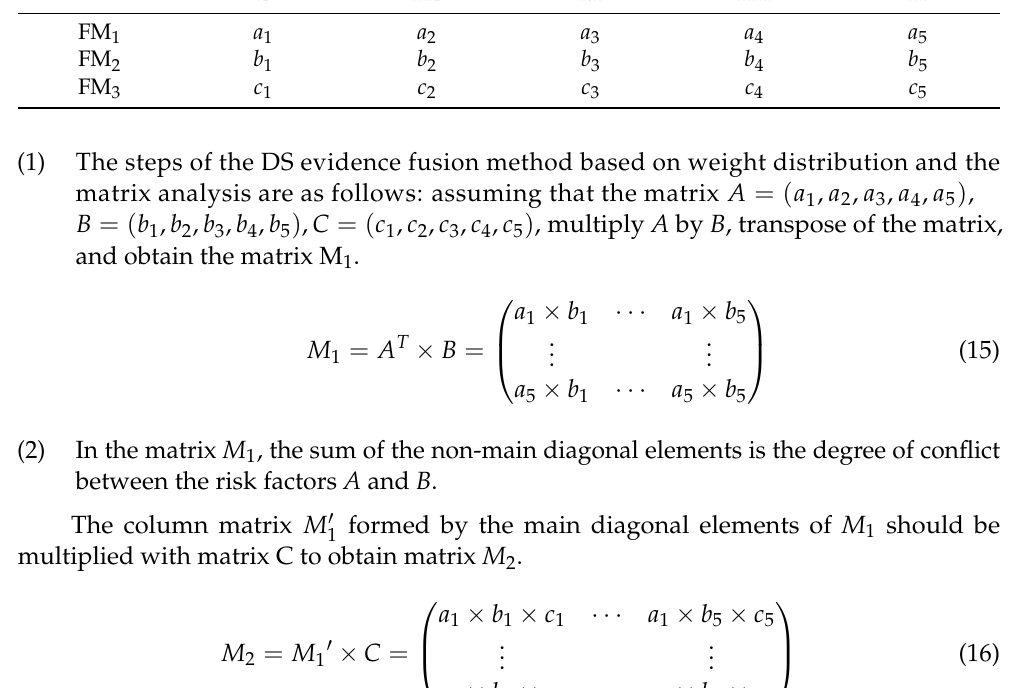
Table 11. Evaluation results of three types of risk factors. Risk